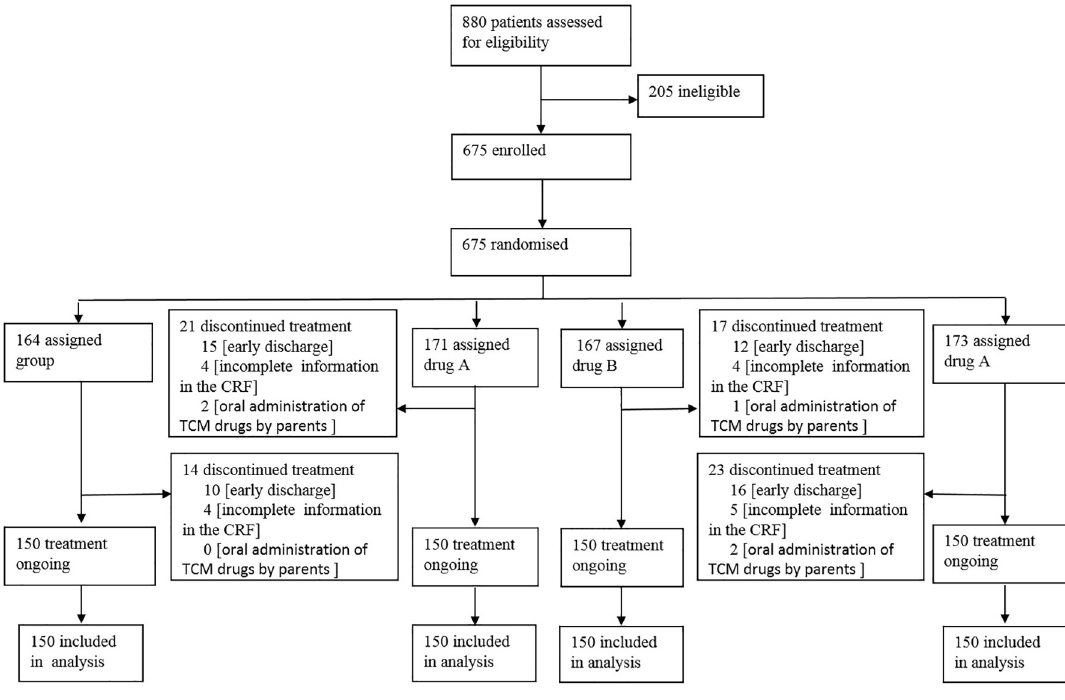
Fig 1. The flow diagram of this